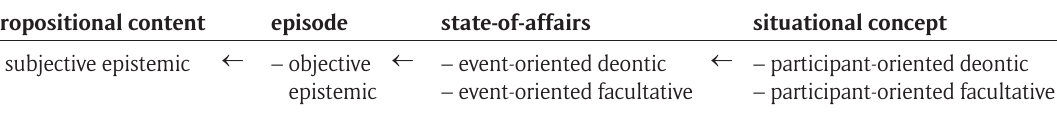
Table 3: Diachronic developments in the field of